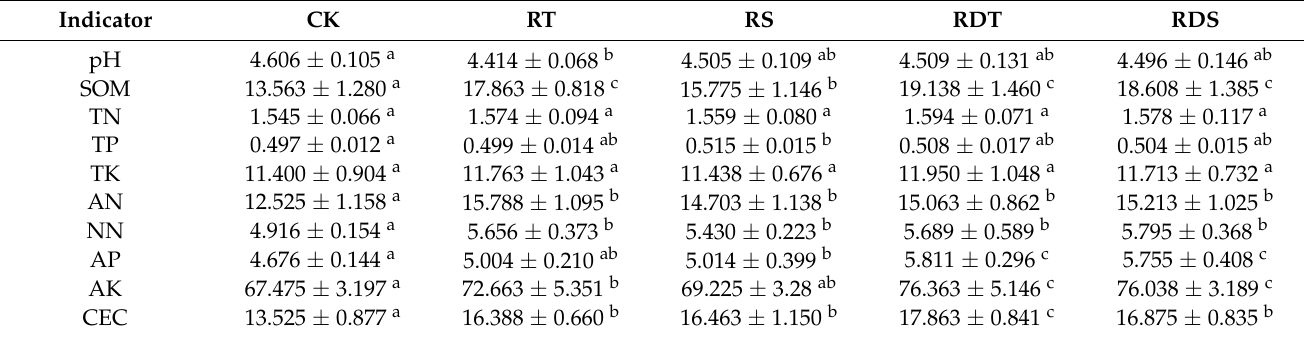
Table 4. Soil chemical properties of different residue treatment methods.